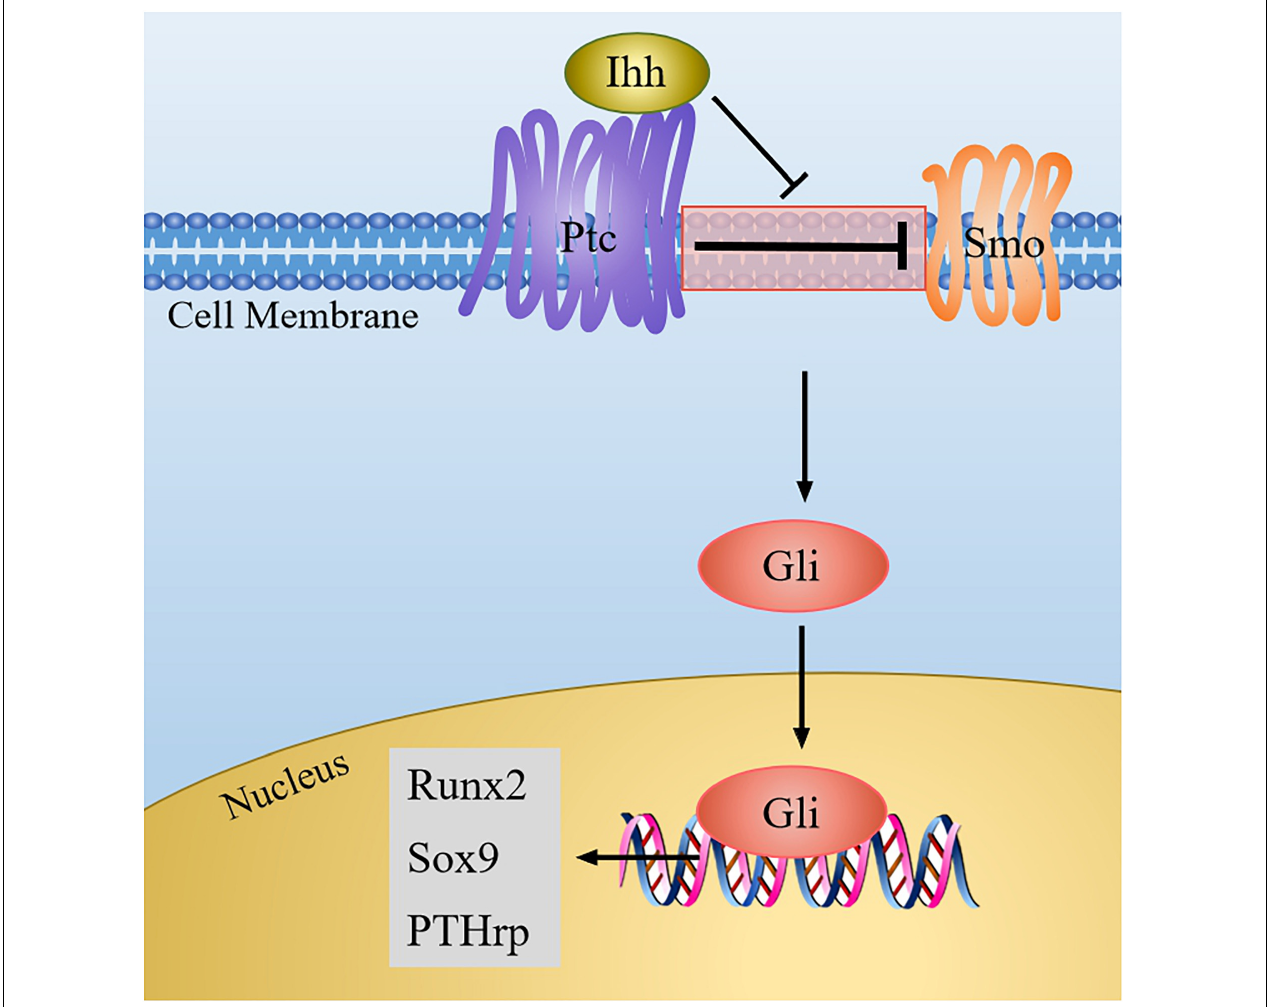
FIGURE 3 | The Ihh signaling pathway in chondrocytes. When Ihh signaling is produced, it binds to Ptc, and then the inhibition of Ptc on Smo is relieved, which result in the activation of Gli. Next Gli enters the nucleus to regulate the expression of target genes (Sox9, Runx2,